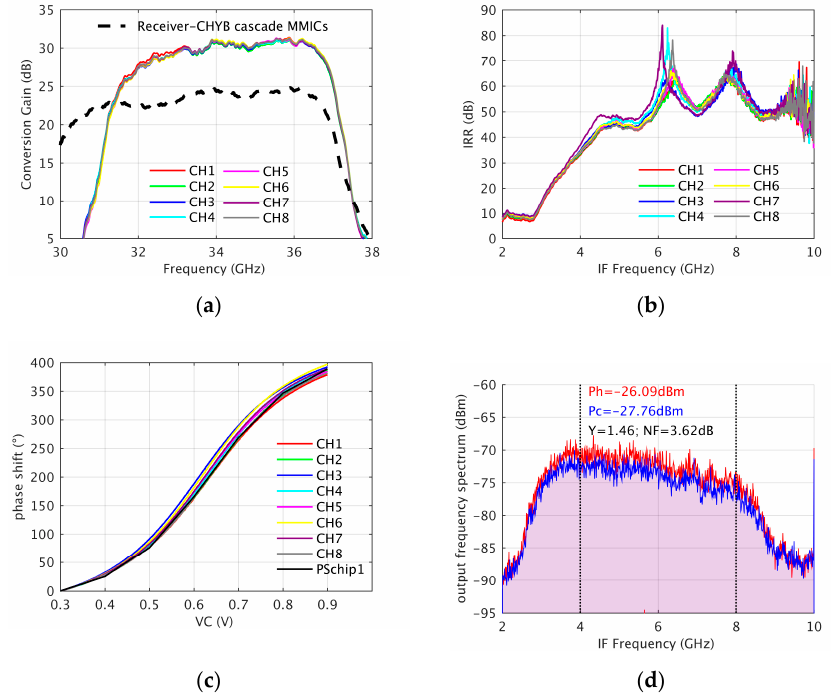
Figure 24. ( a ) Frequency conversion gain measurement results. ( b ) Image rejection ratio measurement results. ( c ) Phase shift range measurement results. ( d ) Noise figure measurement results.